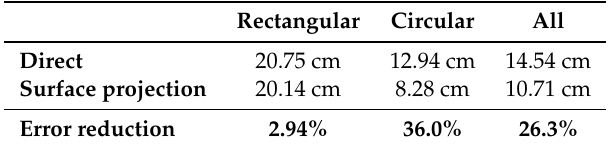
Table 4. Average distance between detections and reference